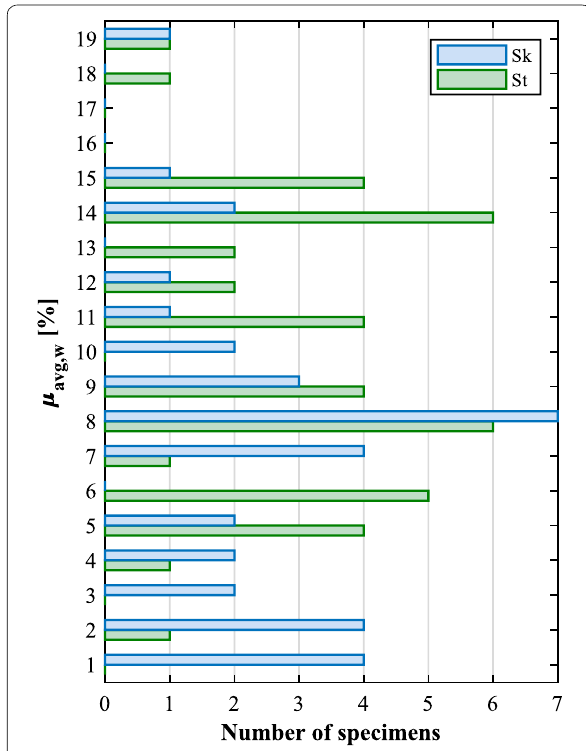
Fig. 5 Corrosion level number of specimens.